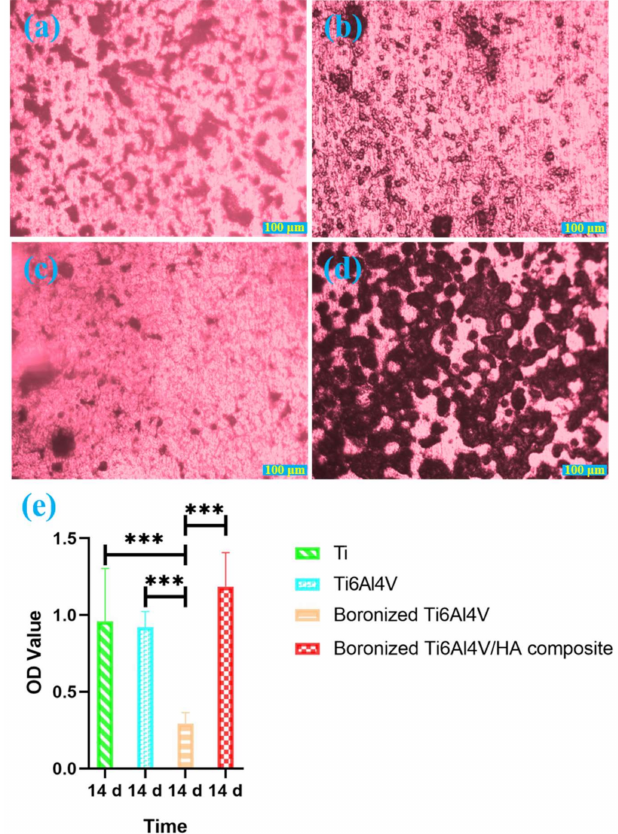
Figure 5. Alizarin red staining of cells cultured on the different specimens for 14 days: ( a ) Ti, ( b ) Ti6Al4V, ( c ) boronized Ti6Al4V, ( d ) boronized Ti6Al4V/HA composite, and ( e ) mineralized nodules of cells cultured on the different specimens for 14 days (*** p <